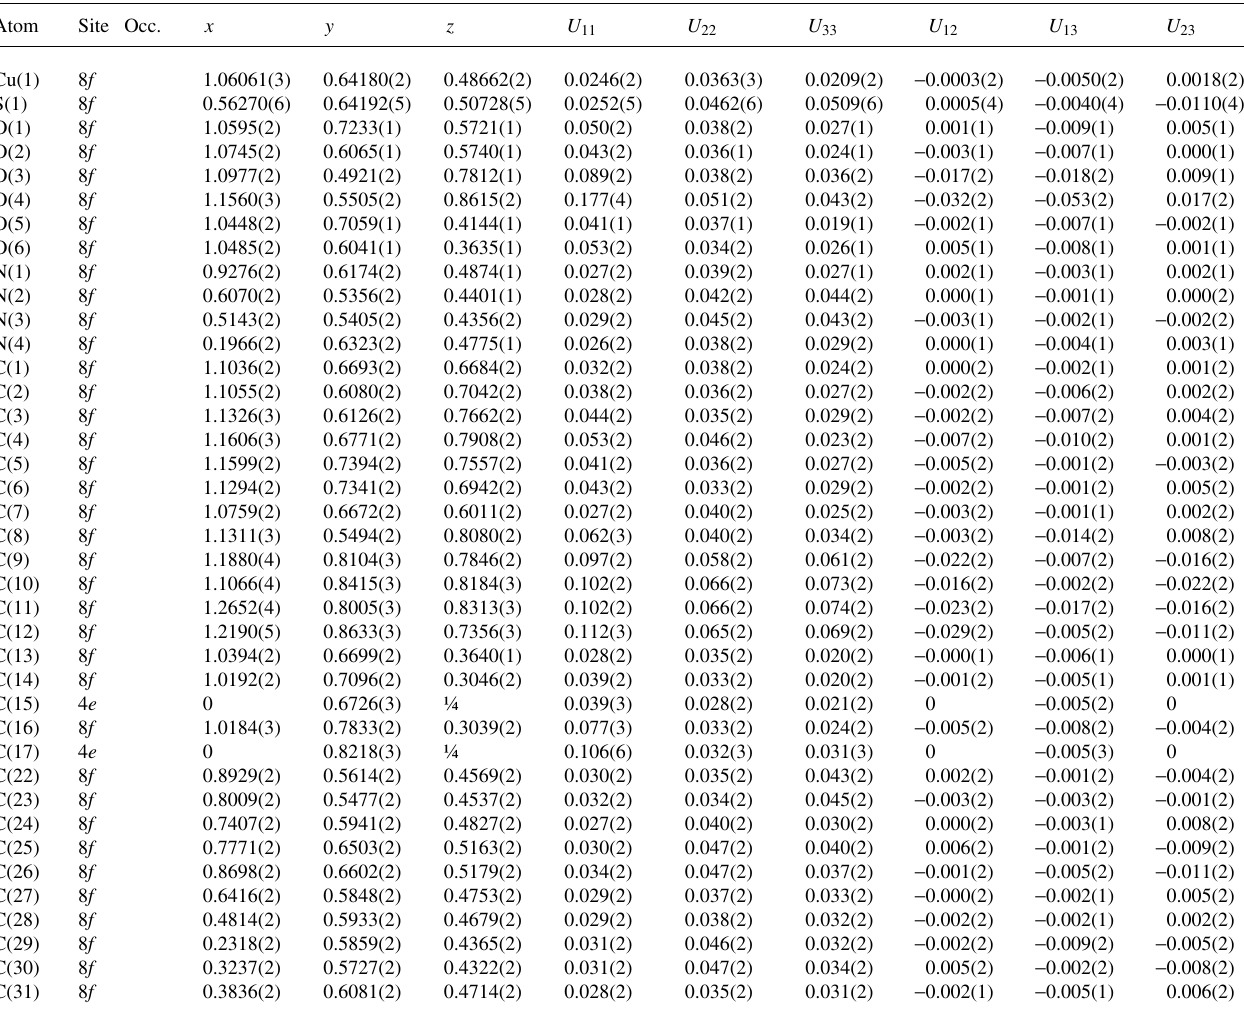
Table 3. Atomic coordinates and displacement parameters (in Å 2 ) .